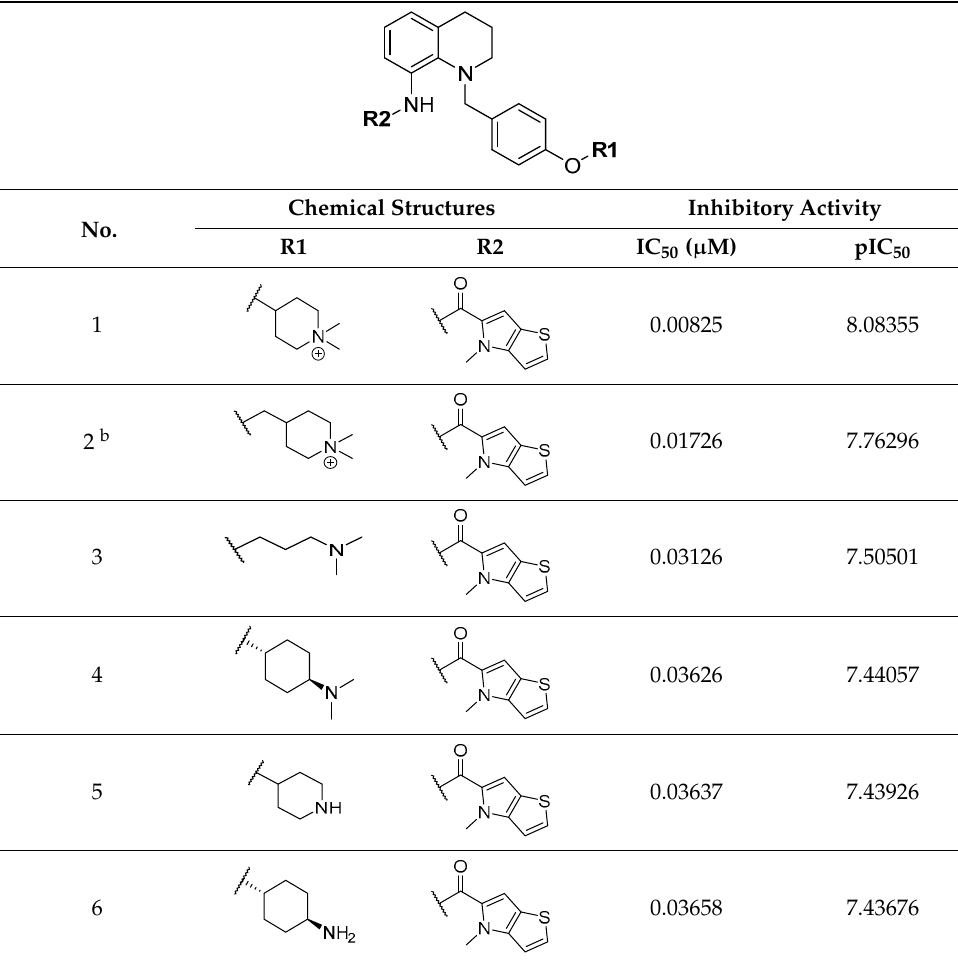
Table 8. Structures and inhibitory activity of tetrahydroquinoline derivatives.